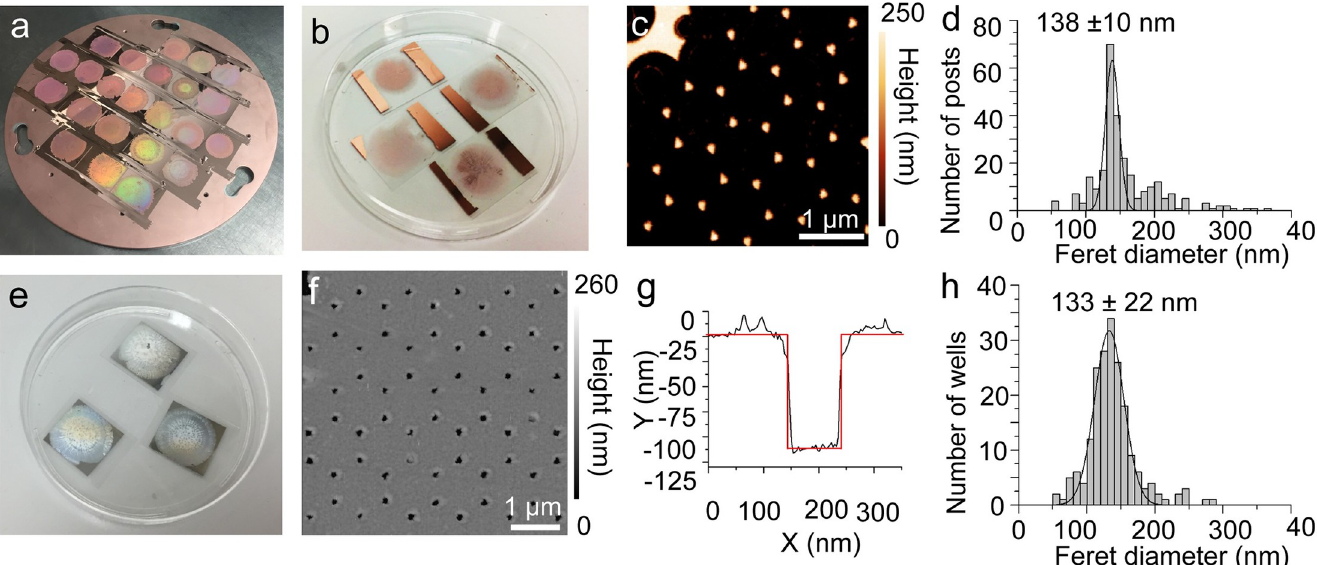
Fig 3. AFM characterization of Al devices. (a) Structural coloration from the bead diffraction pattern following Cu evaporation. (b) Coverslips with centers patterned by arrays of copper posts following dissolution of polystyrene beads by toluene and tape pull of copper that had coated the tops of the beads. (c) AFM image of Cu posts on coverslip. (d) Distribution of apparent maxFeret diameter at half-maximum height of posts formed using a bead template annealed for 20 s. (e) Completed Al ZMWs. (f) AFM of ZMW wells formed after dissolving the narrow Cu posts. (g) AFM profile of depth of individual well. (h) Distribution of apparent maxFeret diameters of wells in Al ZMW measured at half-maximum